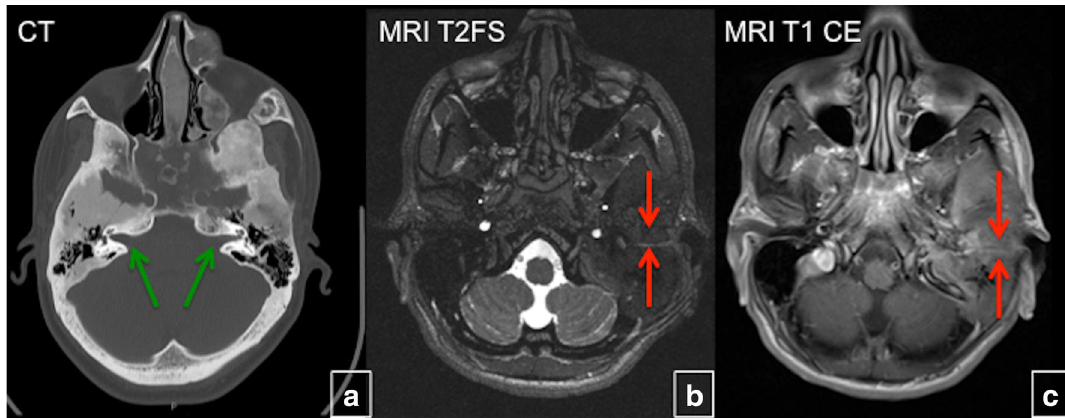
lesion centred in the left petrous temporal bone with near complete obliteration of left external auditory canal ( blue arrow ), which contributes to patient ’ s hearing loss ( green arrow